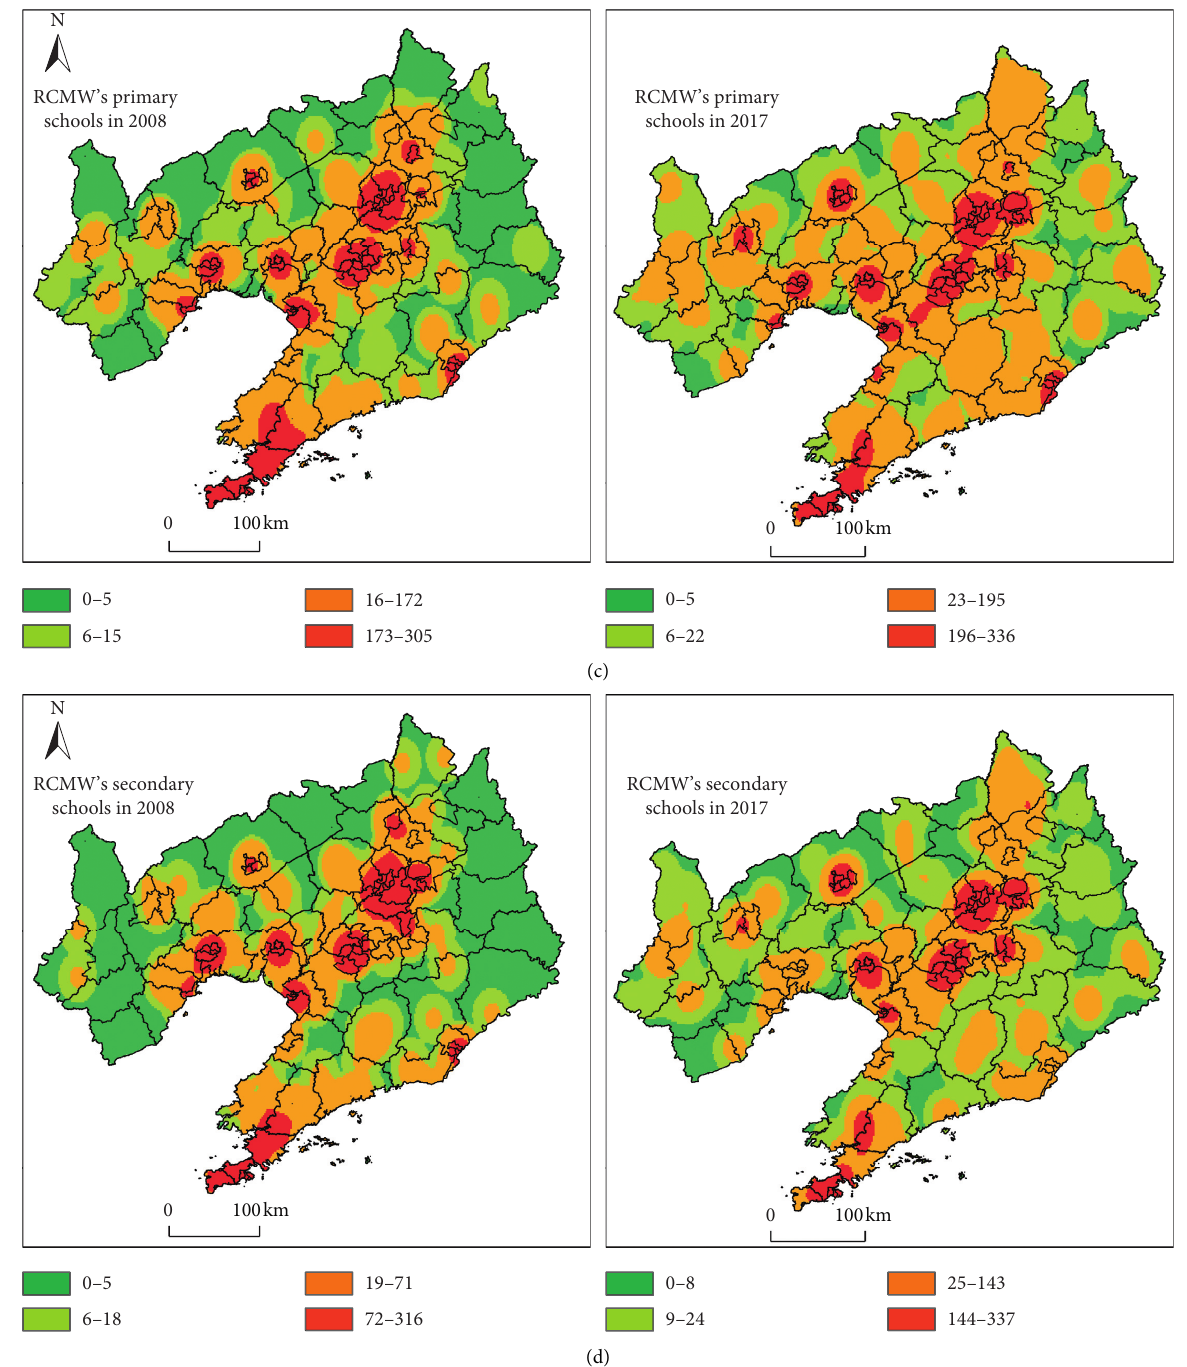
Figure 8: Distribution density map of RCMW and their primary and secondary schools in Liaoning Province in 2008 and